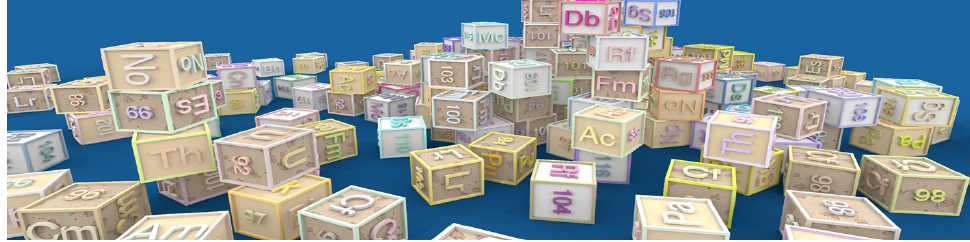
Figure 1. Logo of the virtual workshop on the Atomic Structure of Actinides & Related Topics , 26–28 May